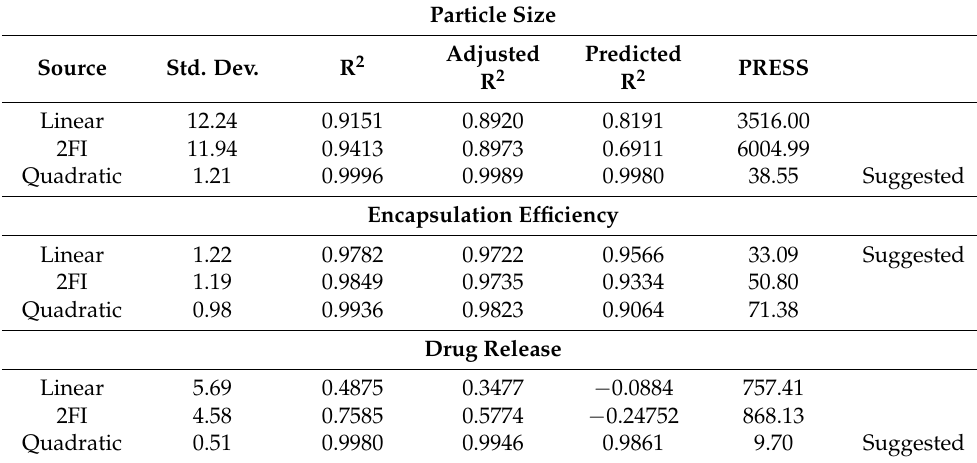
Table 3. Model statistical summary of all applied models for selected